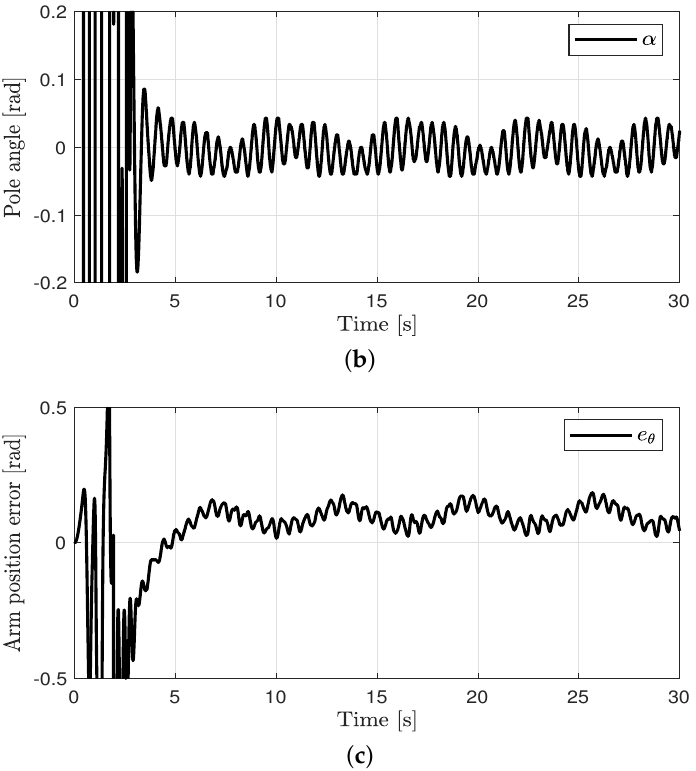
Figure 4. Control performance in case 2. ( a ) Arm position (case 2). ( b ) Pendulum pole position (case 2). ( c ) Arm position error (case 2).